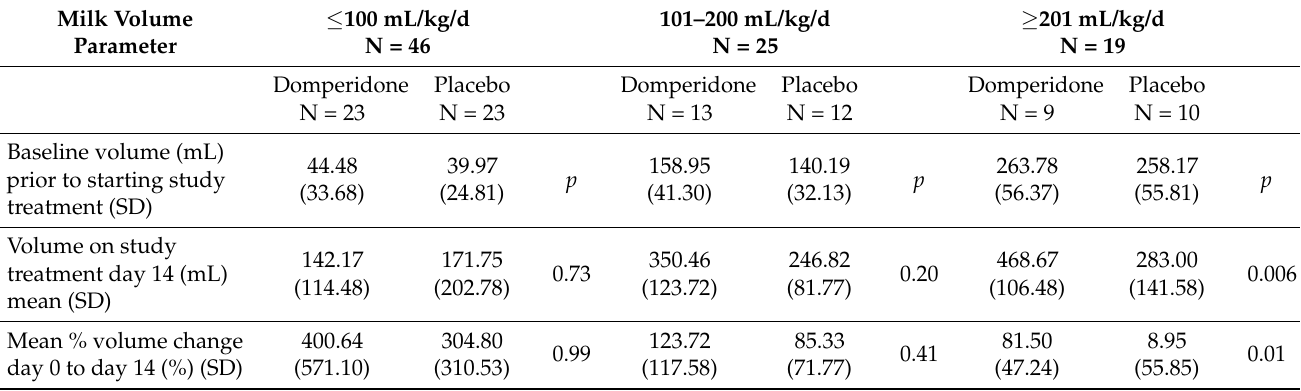
Table 3. Milk volumes at study time points day 0 and day 14 according to EMPOWER study allocation.